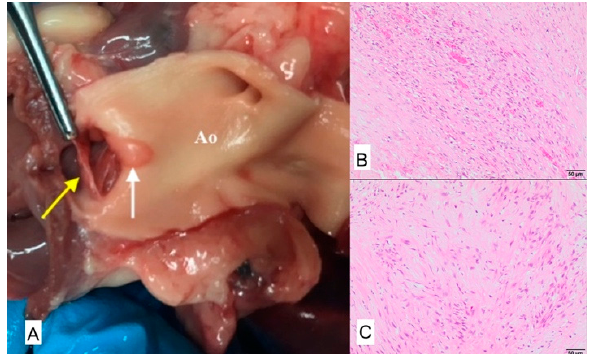
Figure 12. ( A ) Macroscopic view of aorta. Yellow arrow poins to the thicked aortic valve leaflet, white arrow poitns to the proliferative lesion on the aortic wall, Ao—Aorta. Microscopic view: chronic endocartitis with massive valvular fibrosis. ( B ) Fibrovascular tissue of aortal valve; H-E, magnification 100×. ( C ) Fibrous connective tissue of mitral valve; H-E, magnification 100×).